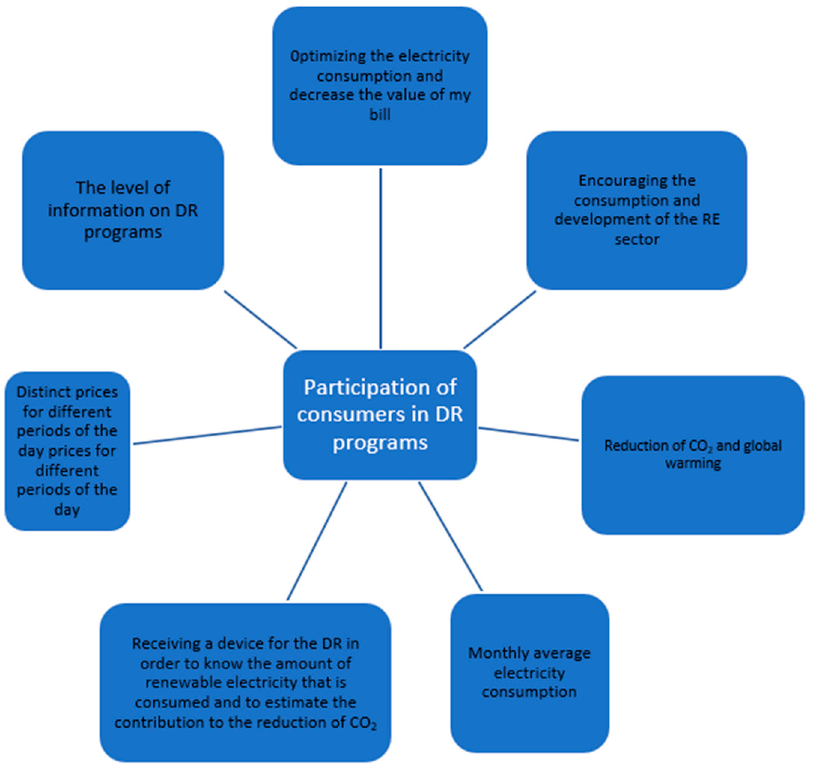
Figure 4. Estimated factors which influence the participation of consumers in demand response programs.